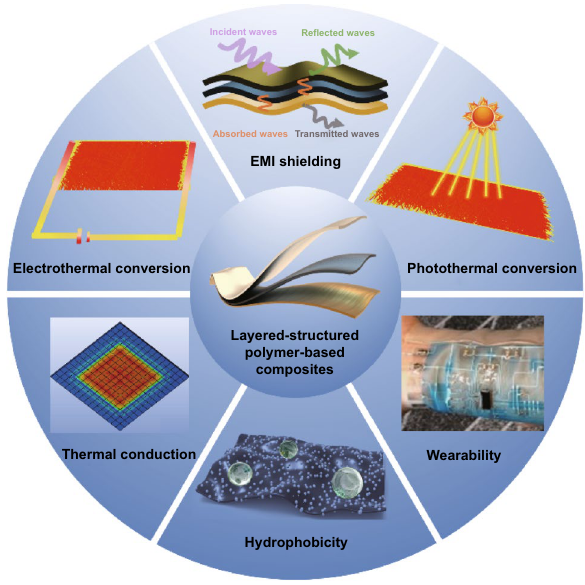
Fig. 3 Schematic diagram of multifunction compatibility design for layered-structured polymer-based EMI shielding